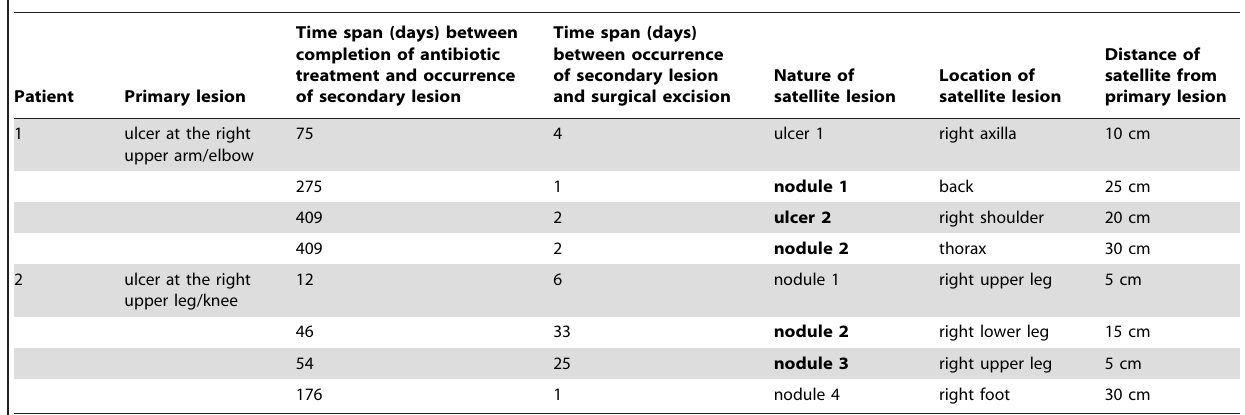
Table 1. Features of skin lesions that emerged after completion of antibiotic treatment.